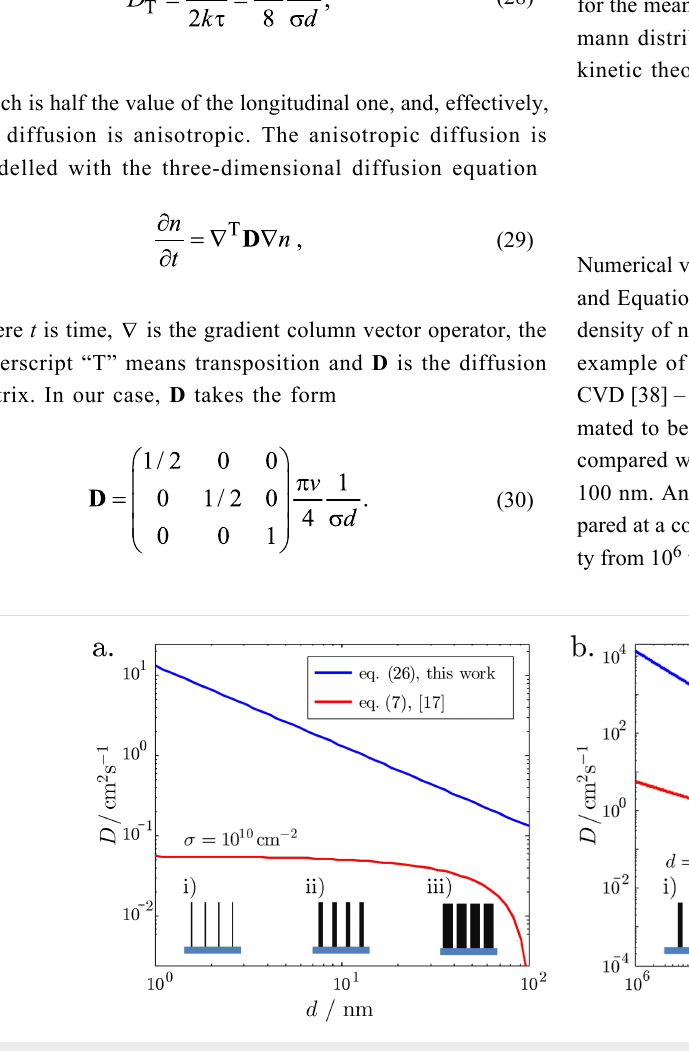
Figure 7: Comparison of the diffusion coefficient introduced in this work given by Equation 26 and the one from [17] given by Equation 7. The mole- cule velocity was taken as v = 171 m/s. a) Diffusion coefficient versus tube diameter d at a constant cylinder areal density σ = 10 10 cm − 2 . b) Diffusion coefficient versus cylinder areal density σ at a constant mean diameter d = 10 nm. The insets show schematically the altered parameter of the struc- ture on the horizontal axis (for the sake of clarity, the randomisation of diameters and positions are not